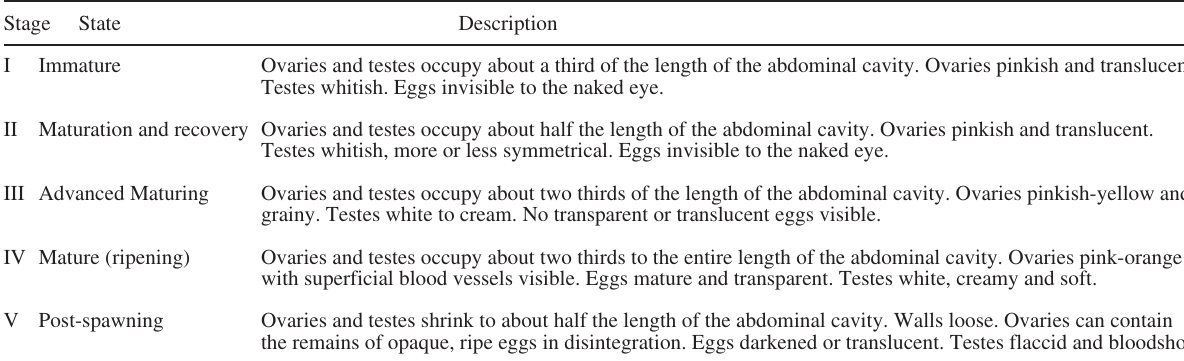
Table 2. – Maturity scale for partial spawners (Holden and Raitt,